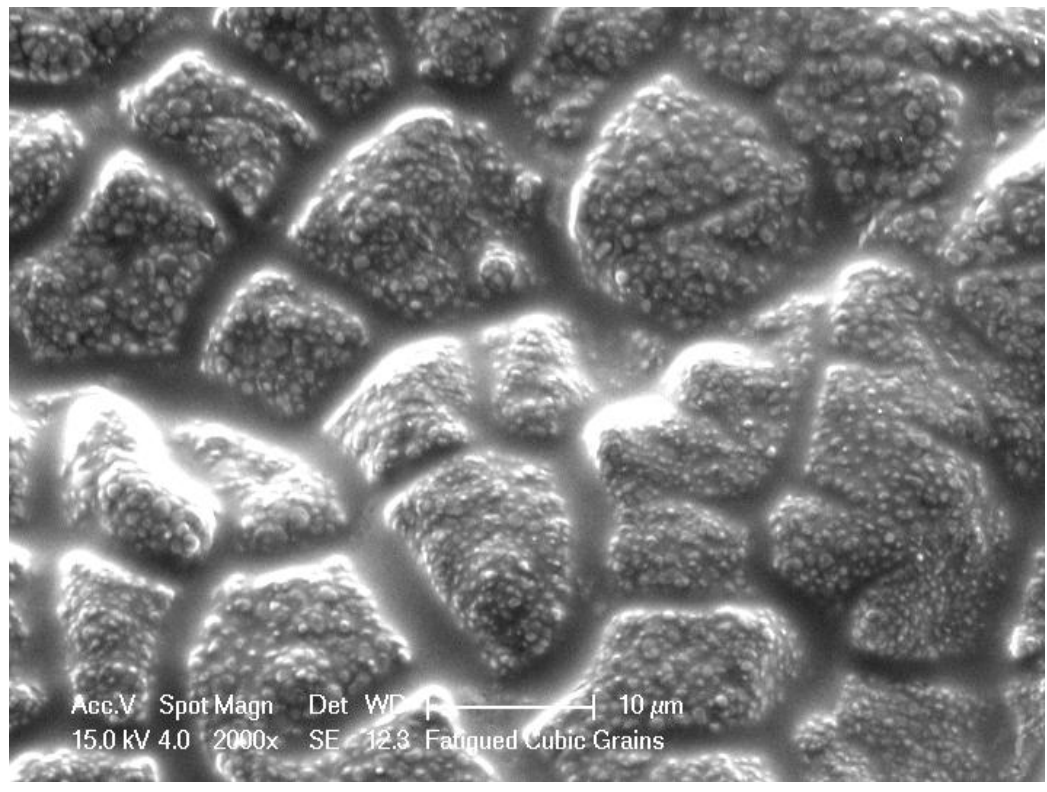
Figure 1. SEM image, 2,000×, demonstrating thickening of grain boundaries after cyclic loading observed for all examined